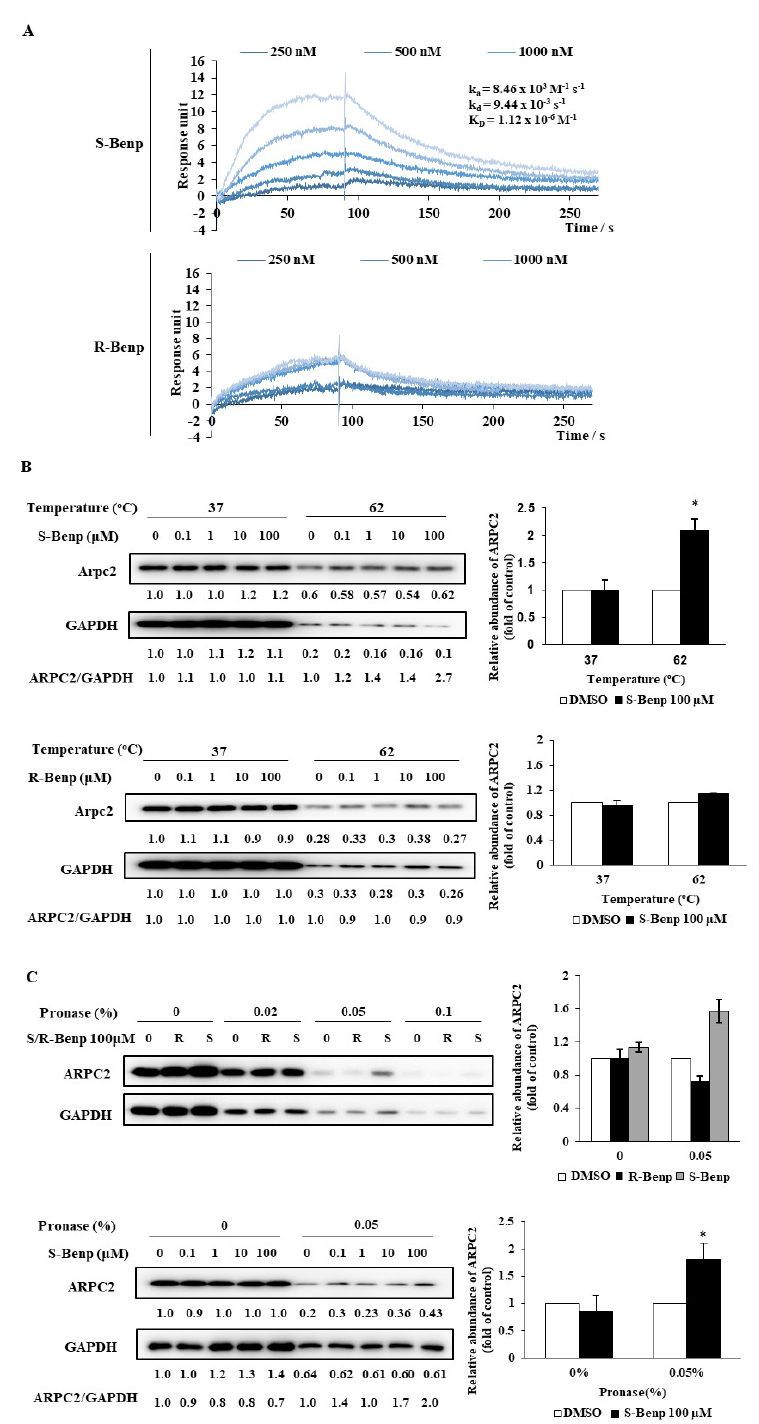
Figure 4. Direct binding of S-Benp with ARPC2. ( A ) Analysis of the interaction between ARPC2 and R- or S-Benp by SPR. After the immobilization of ARPC2 on the CM5 sensor chip, each concentration of R- or S-Benp was injected over the protein surface. Dissociation of R- or S-Benp was measured and analyzed by fitting the sensorgrams to the 1:1 binding model. ( B ) CETSA after incubation with DLD-1 cell lysates with DMSO or isoforms of Benp. ( C ) DLD-1 cell lysates were proteolyzed after incubation with DMSO or isoforms of Benp. The graph shows the quantification of the ARPC2 intensity with normalization against GAPDH (nontarget protein). The data represent means ± s.d.; comparisons were performed with t tests (two groups); * p <